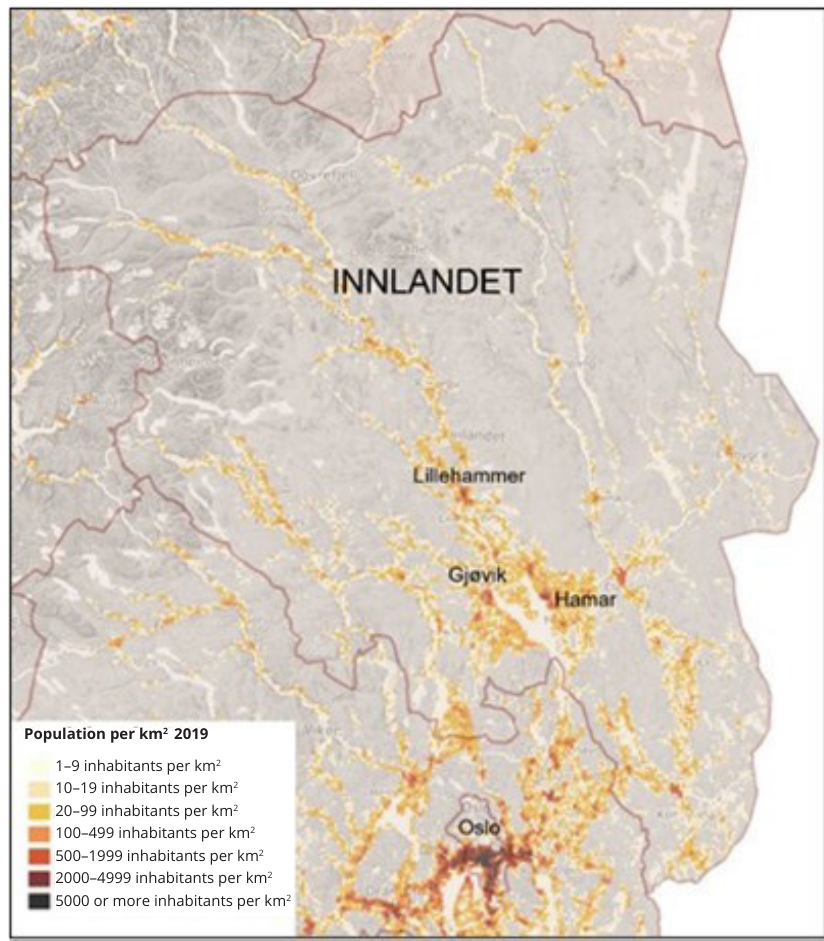
Fig 3. Inhabitants per km 2 in Innlandet 2019. (Source: Statistics Norway